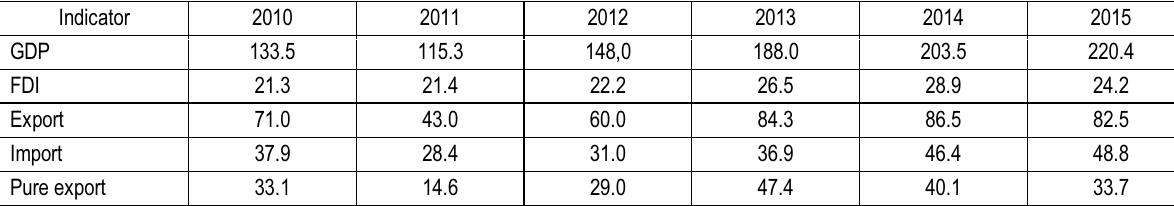
Table 1. Key figures based on correlation analysis